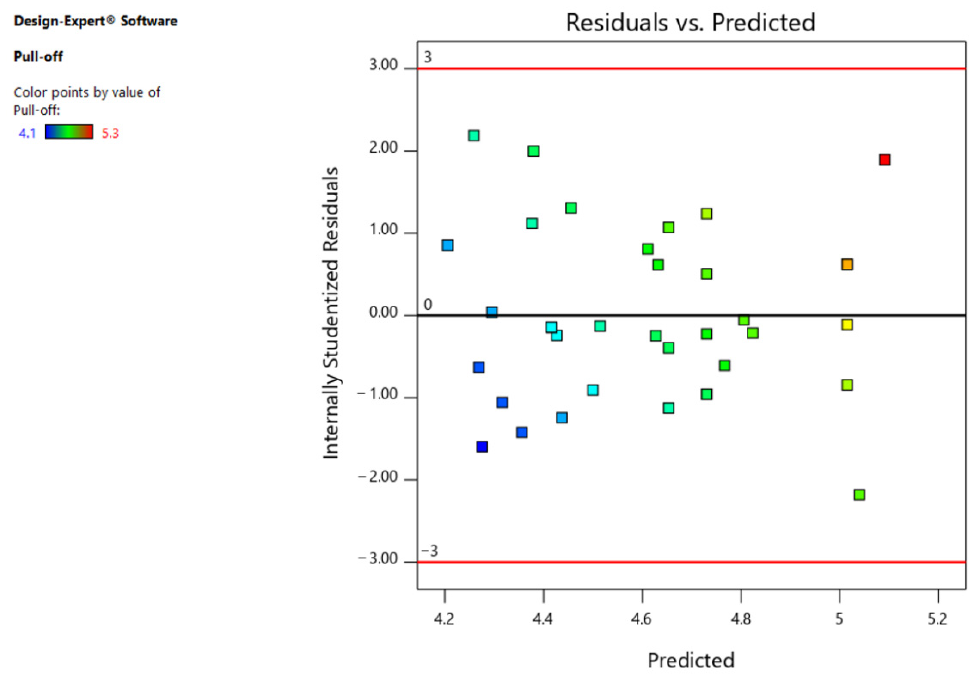
Figure 6. Checking the assumption on normal distribution for adhesion force.